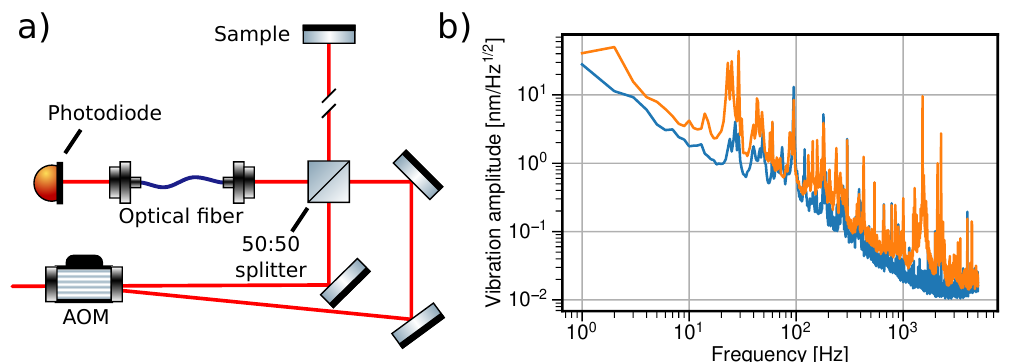
Figure 6: Vibration characterization. (a) Schematic of the interferometer setup used to measure vertical vibrations. A laser beam (red) is split by an acousto-optic mod- ulator (AOM). The zero-order transmitted beam is reflected off the sample before being recombined with the first diffraction order on a beam splitter. The two beams are then coupled to an optical fiber and interfered on a photodiode. The resulting intensity signal contains a 70 MHz beat from the AOM frequency shift, as well as a slower signal caused by motion of the sample that changes the relative phase of the two beams. (b) The spectral density of vibrations is plotted with the cold head on at 6.1 K (orange) and off at room temperature